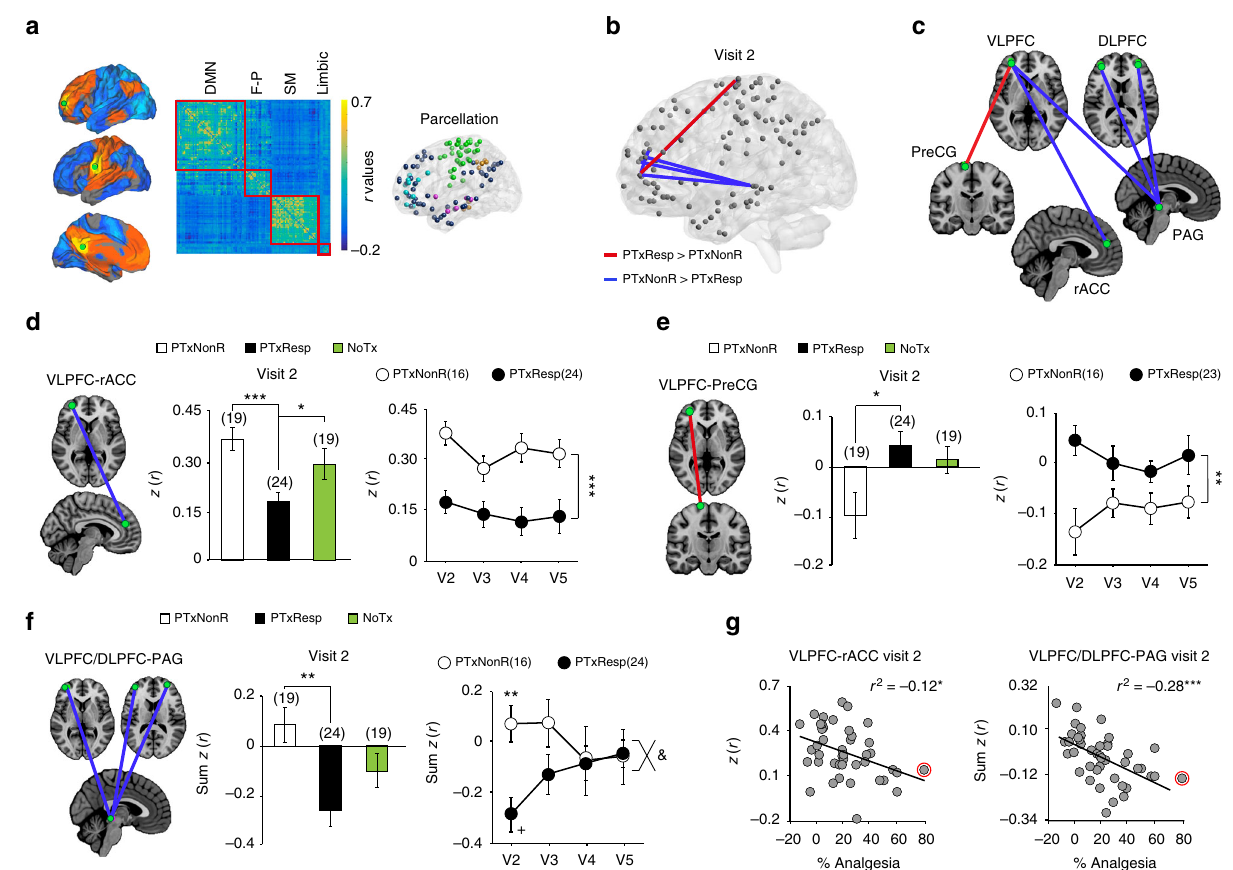
Fig. 4 Placebo pills response identi fi es a lateral prefrontal functional network with invariant and transient components. a Previous results indicate that functional connectivity in four regions: middle frontal gyrus (MFG), rostral-anterior and posterior cingulate cortex (rACC, PCC), and sensorimotor (SM) cortices predict placebo response in OA patients 22 . Co-activation maps derived from these seeds (green) (1000 healthy subjects from http://neurosynth. org) were used to restrict brain networks of interest. The connectivity matrices of our data were restricted to communities overlapping with these networks of interest: default mode network (DMN), frontoparietal (F-P), sensorimotor (SM), and subcortical limbic. b , c A permutation test was performed on the weighted 7381 resting state connections between all possible pairs of nodes within the modules of interest (FDR-corrected p < 0.05). Stronger connectivity link Ventrolateral prefrontal cortex (VLPFC)-Precentral gyrus (PreCG) and weaker connectivity links VLPFC-rACC, and VLPFC/DLPFC-periaqueductal gray (PAG) identi fi ed placebo responders prior to treatment (visit 2). d – f VLPFC-PreCG and VLPFC-rACC connections differentiated placebo